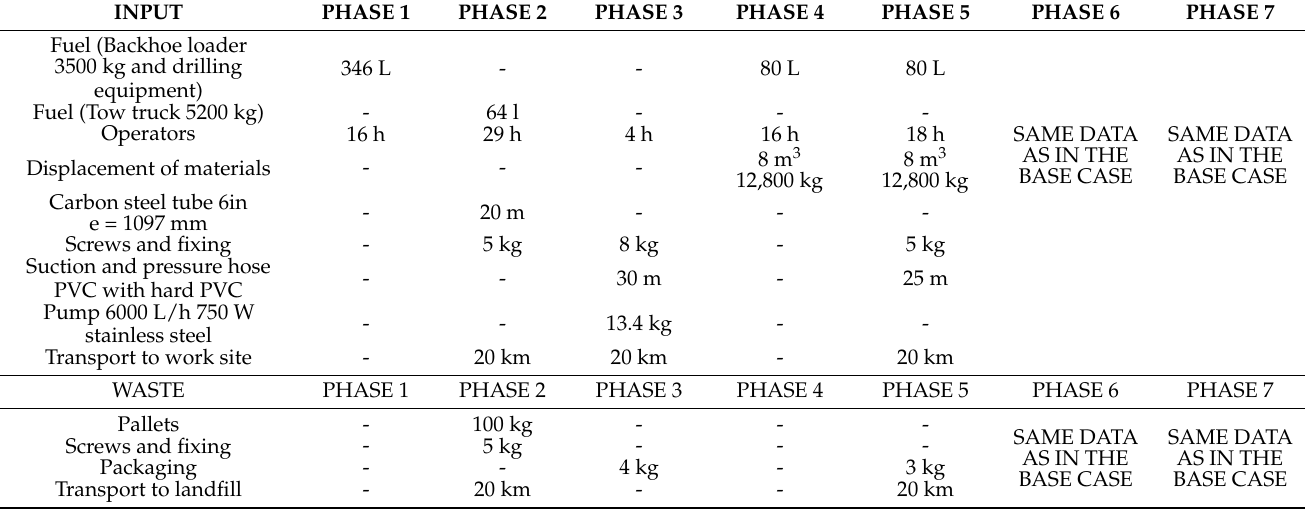
Table 2. Alternative B